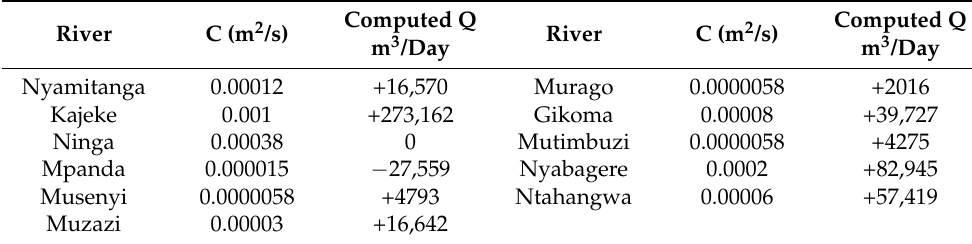
Table 5. Optimized conductance (C) and computed flux (Q) through the different portions of the rivers represented within the model (+: aquifer drains river; −: river drains aquifer).